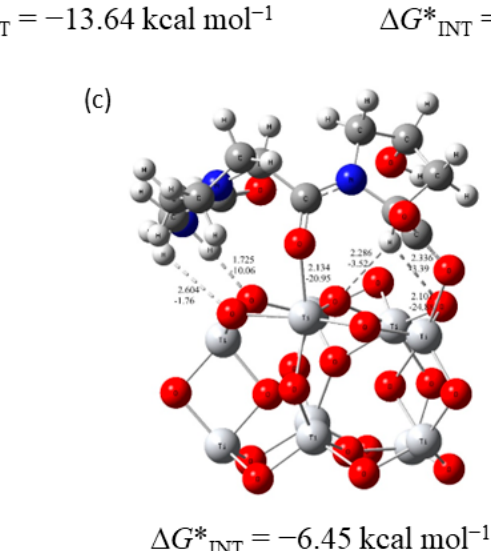
Figure 4. The most stable structures predicted by DFT of ( a , b ) the (TiO 2 ) 10 –alendronate [13] and ( c ) the (TiO 2 ) 10 –tripeptide representing hydrolysed collagen. Bond distances are in Å and bond energies are in kcal mol − 1 . Oxygen—red ball; Nitrogen—blue ball; Phosphorus—orange ball; Titanium—light grey